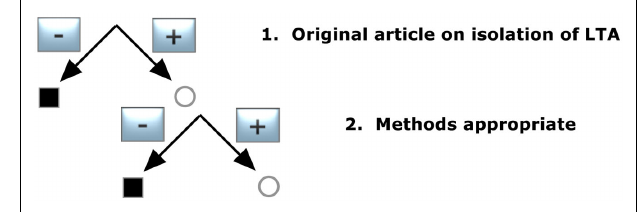
FIGURE 1 | Decision tree 1 (Koch–Dale criterion